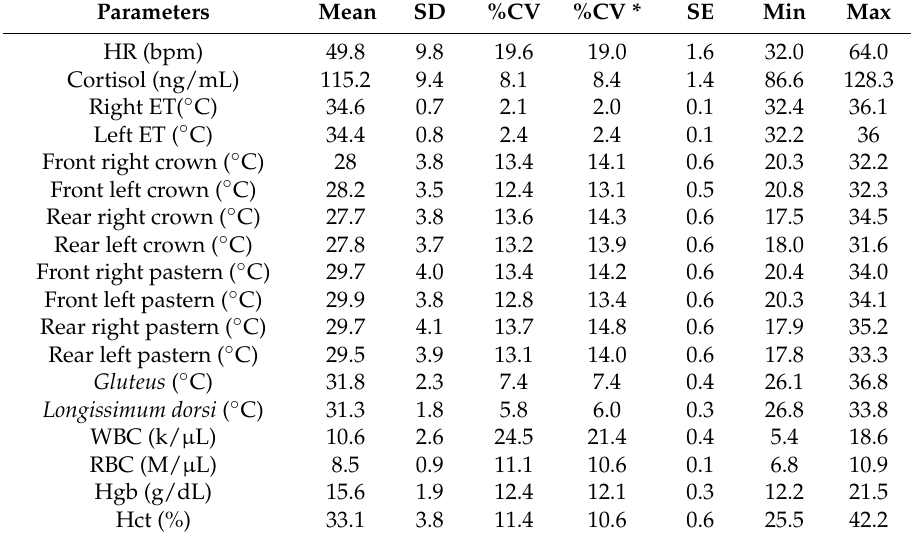
Table 3. Descriptive statistics of the parameters measured with means, standard deviations (SDs), percent coefficients of variation (%CV), standard errors (SEs), and minimum (Min) and maximum (Max) observed